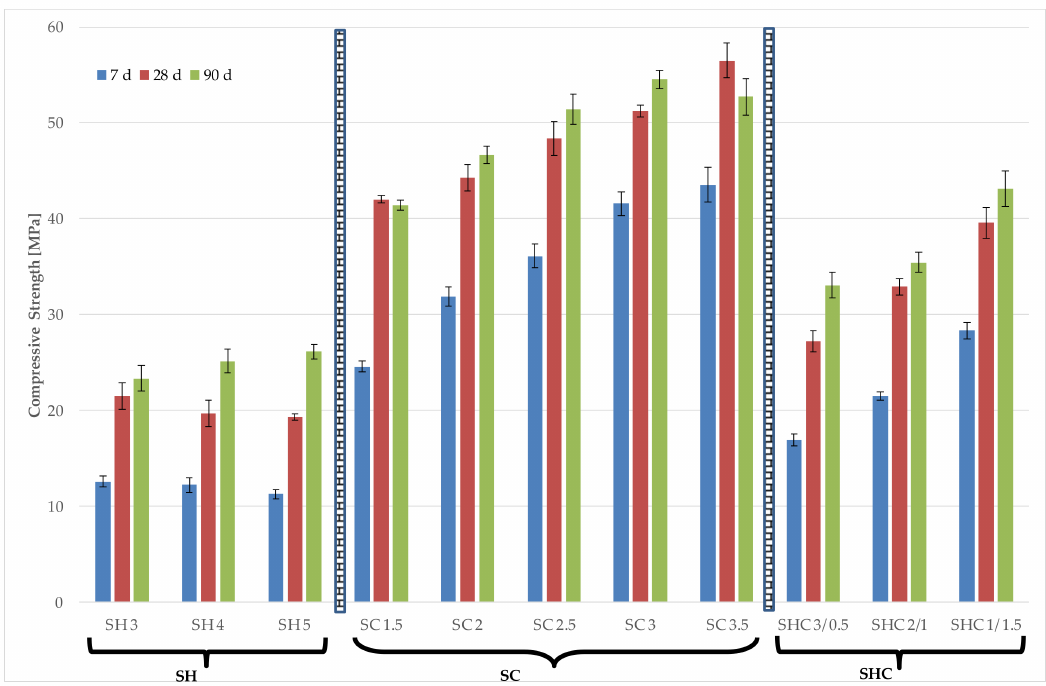
Figure 5. Compressive strength (Rc) of mortars for 3, 28 and 90 curing